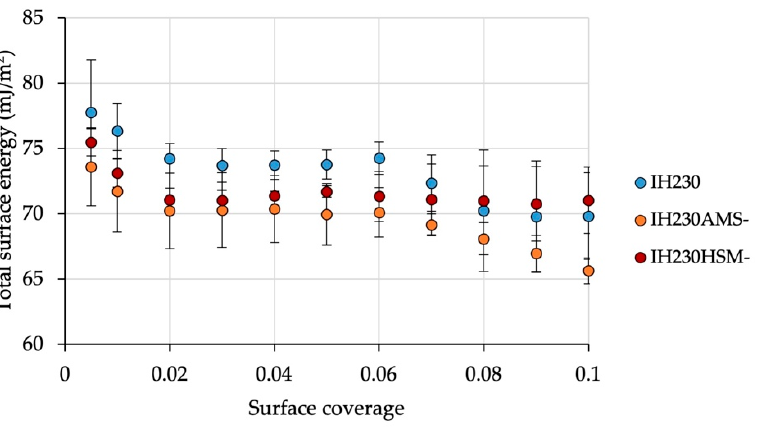
Figure 7. Total surface energy of the raw material in comparison to processed powders without the additive. n = 3, error bars show SD.